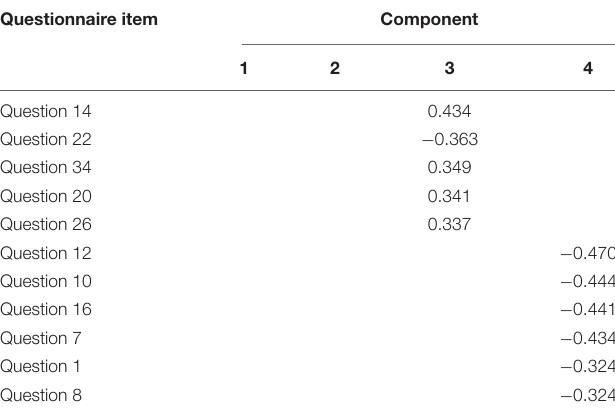
TABLE 1 | Forced four-factor component